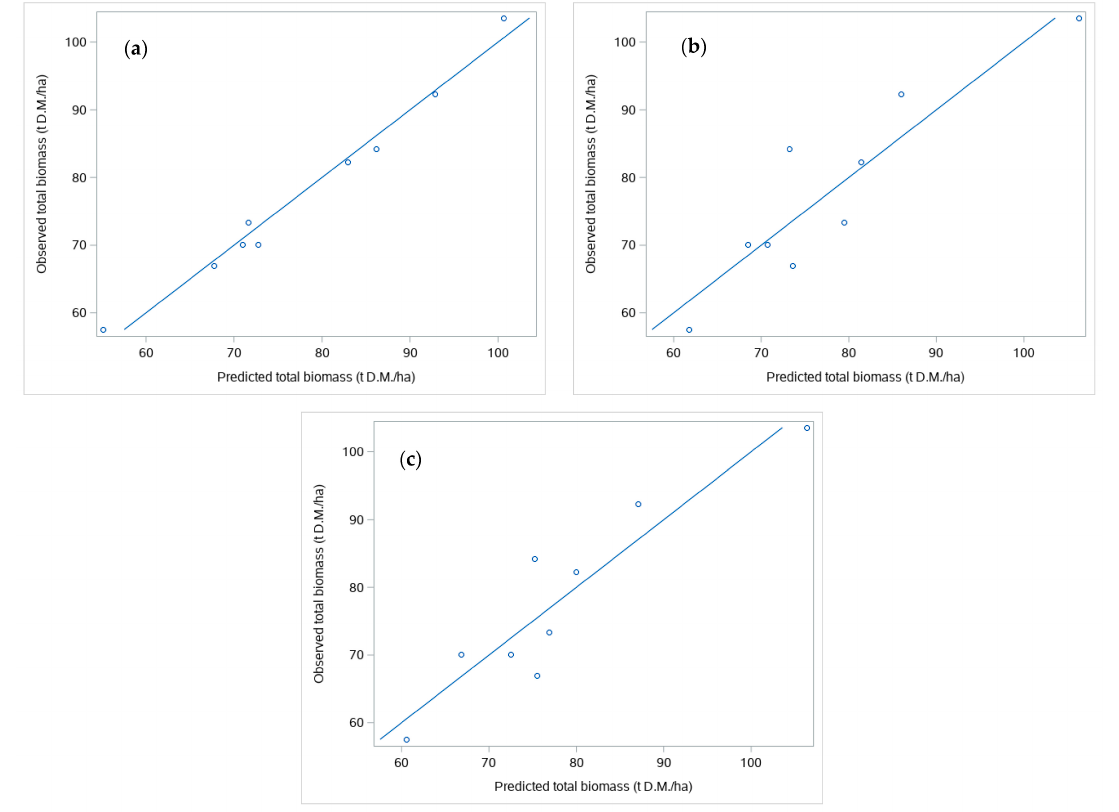
Figure 7. Concordance between observed and predicted values of total biomass for the TLS model ( a ), Field-inventory model ( b ), and combined model ( c ). Straight lines indicate the